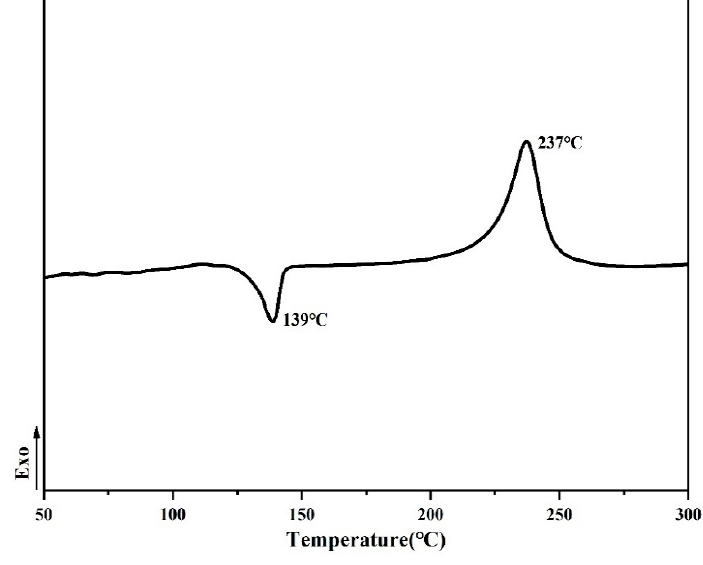
Figure 8. DSC of the ANP monomer.